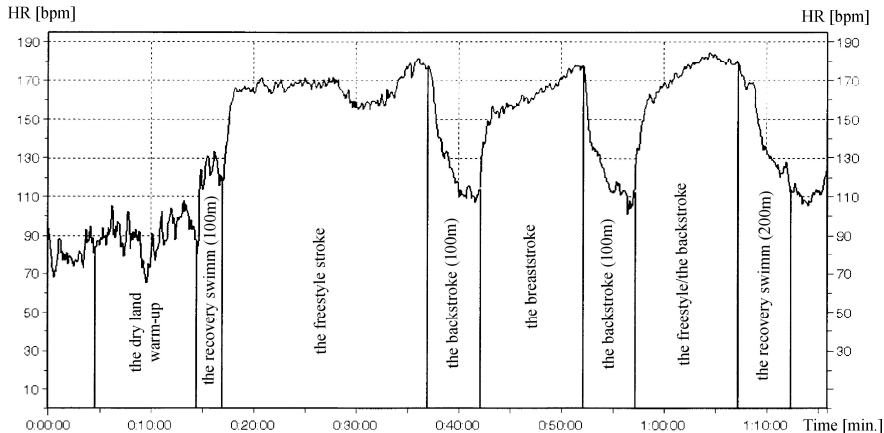
Figure 1. One of the heart rate (HR) profiles and structure of one of the single sessions during 12-week swimming swimming training.